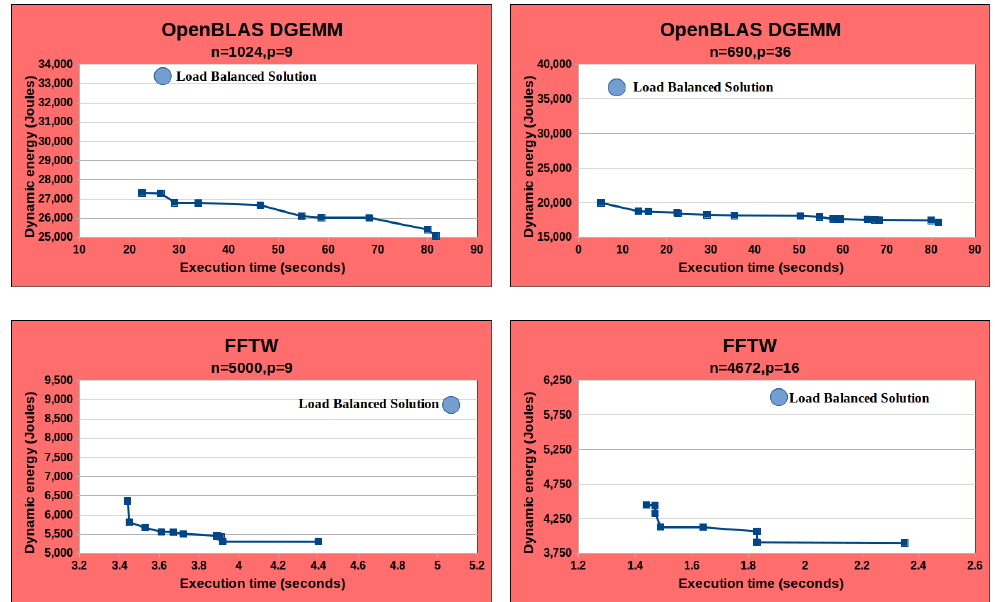
Figure 10. Pareto fronts for OpenBLAS DGEMM and FFTW applications for two different workload sizes ( n ) and the number of homogeneous processors ( p ). The workload size n is given in multiples of fixed granularity (a basic computation unit that does not differ during the application execution). The Pareto front is the line connected by blue square points. The load-balanced solution is shown as a blue